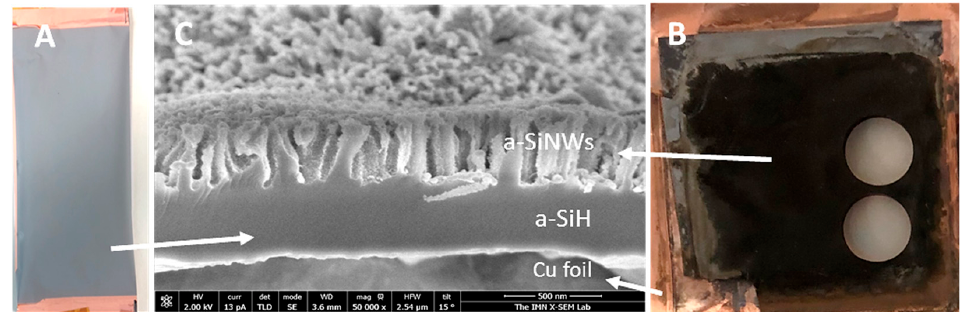
Figure 2. Optical images of a-Si:H films on Cu foil, ( A ) before the MACE process, ( B ) after the MACE process (the appearance of the a-SiNWs to the naked eye is black due to the anti-reflective effect). ( C ) FESEM image, where a-SiNWs formed by MACE, a-Si:H film underlying and bonded to copper that has not been etched, and Cu foil substrate are indicated with labels.